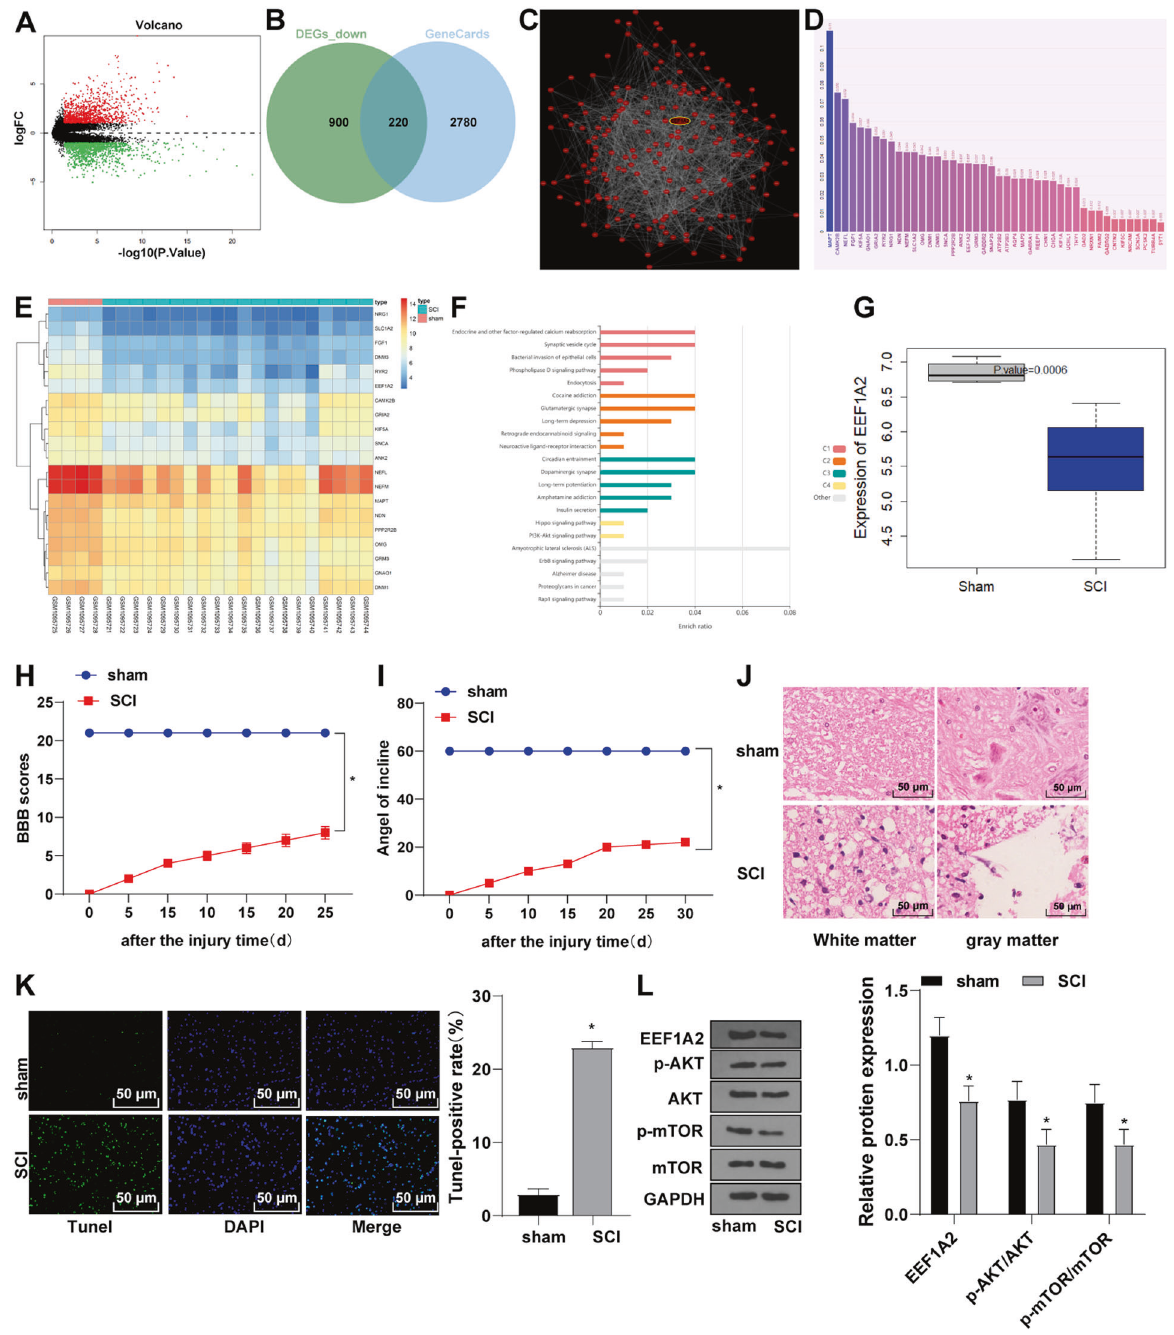
Fig. 1 EEF1A2 was poorly expressed and Akt/mTOR pathway was inhibited in SCI. A differential expression gene map of SCI chip GSE45006, the abscissa represents – log ( p value), the ordinate represents log2FC, red dots indicate highly-expressed genes and green dots indicate lowly-expressed genes; ( B ) Venn map of the intersection of differentially low-expression genes and GeneCards database; ( C ) gene co- expression network by Coexpedia; ( D ) bar graph of the correlation of gene-disease, the abscissa represents correlation score; ( E ) expression heatmap of candidate genes, the color scale represents gene expression from low (blue) to high (red); ( F ) enriched terms visualized in barplot, each row represents an enriched function, and the length of the bar represents the enrich ratio, which is calculated as “ input gene number ” / “ background gene number ” . The color of the bar is the same as the color in the circular network in above, which represents different clusters. For each cluster, if there are more than fi ve terms, top 5 with the highest enrich ratio will be displayed; ( G ) signi fi cant low expression of EEF1A2 in chip GSE45006; ( H ) locomotor ability of rats detected by BBB locomotor rating scale; ( I ) neuronal function detected by inclined plane test; ( J ) pathological conditions of spinal cord assessed by HE staining; ( K ) apoptosis of spinal cord tissues detected by TUNEL staining; ( L ) expressions of EEF1A2 and Akt/mTOR pathway-related proteins detected by Western blot. Data were expressed as mean ± SD. Pairwise comparisons were analyzed using independent t test, N = 5. * vs sham group, p < 0.05.